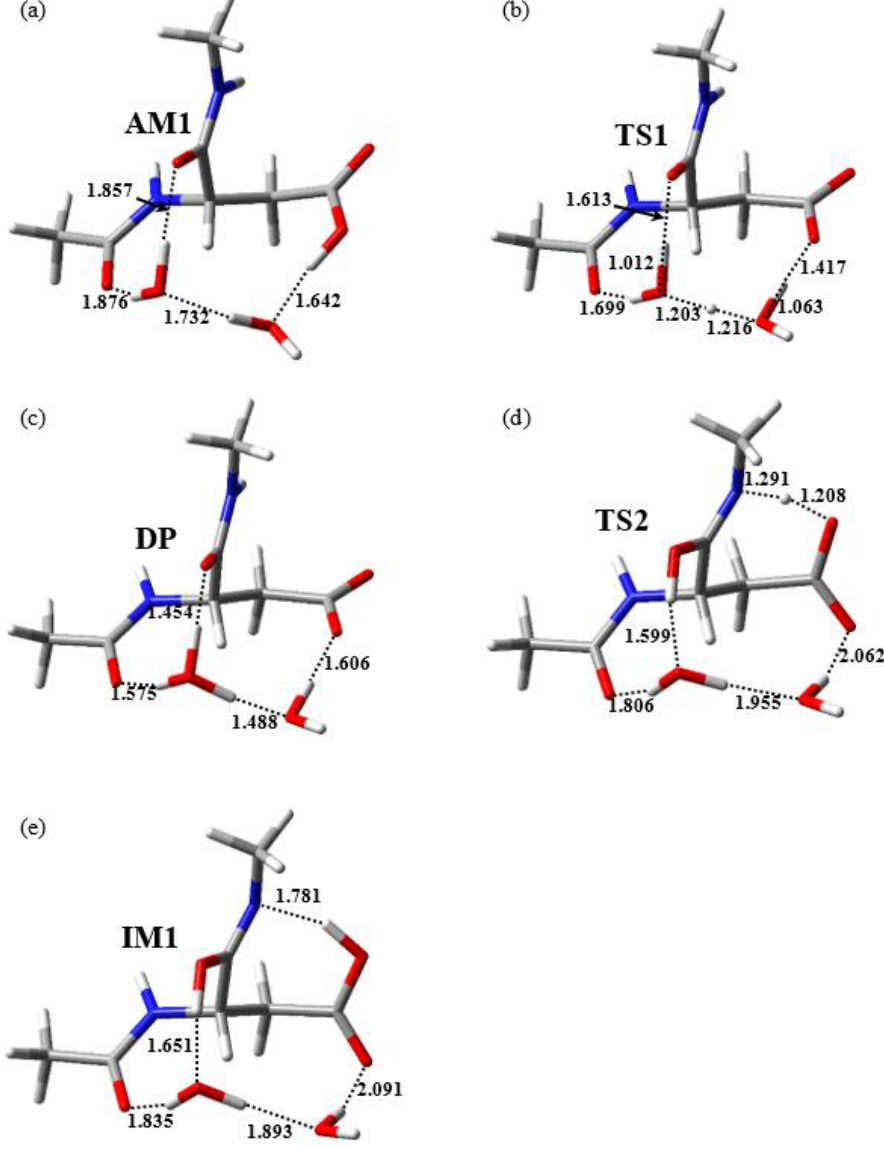
Figure 3. Optimized geometries of ( a ) AM ( φ = −102°, ψ = −85°, χ 1 = 174°), ( b ) TS1 ( φ = −99°, ψ = −89°, χ 1 = −174°), ( c ) the DP ( φ = −98°, ψ = −89°, χ 1 = −172°), ( d ) TS2 ( φ = −113°, ψ = −113°, χ 1 = 178°), and ( e ) IM1 ( φ = −113°, ψ = −103°, χ 1 = −176°). Selected interatomic distances are presented in angstroms (Å ). Carbon, hydrogen, nitrogen, and oxygen atoms are illustrated in gray, white, blue, and red, respectively.